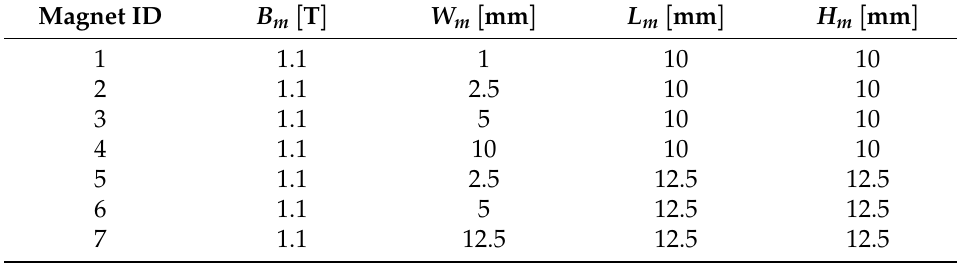
Table 5. Available NdFeB